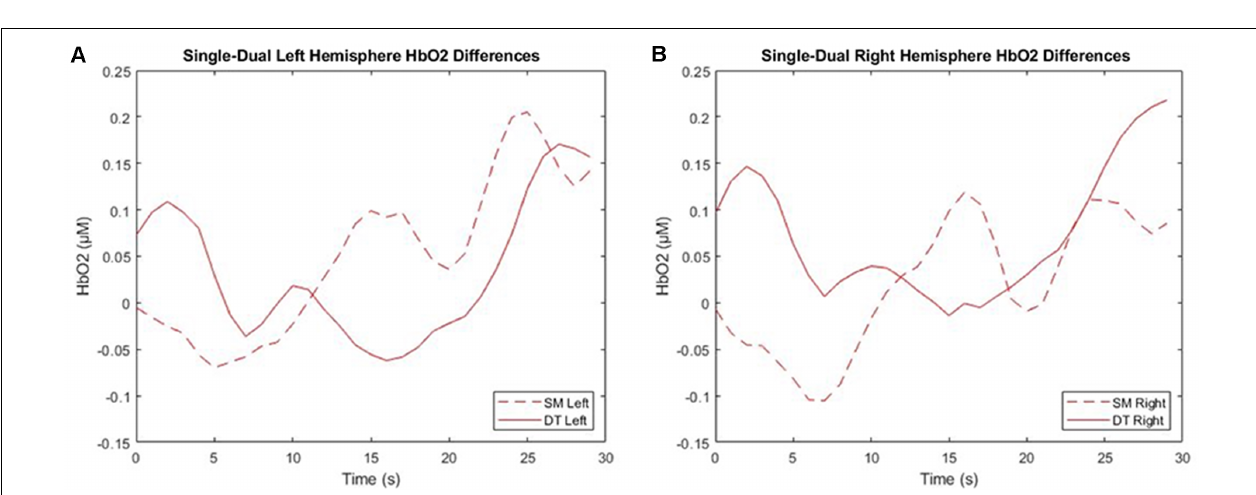
FIGURE 7 | Left (A) and right (B) mean hemispheric changes in cerebral oxygenation ( ∆ HbO 2 ) between single motor (SM) and dual-task (DT) blocks. The right hemisphere consists of channels 1–4 and the left hemisphere consists of channels 5–8. This data is the group average post-processed with baseline subtraction, filtering, and outlier